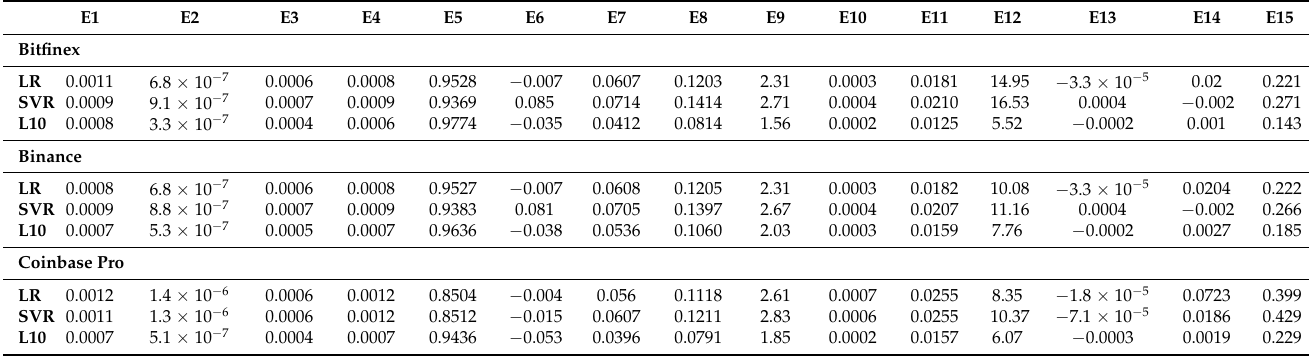
Table 20. Performance comparison with different econometric models.